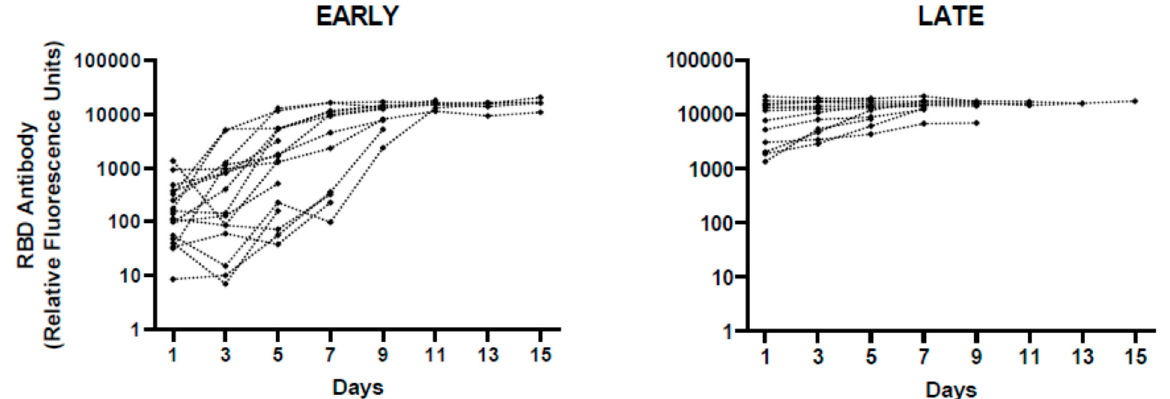
Figure 4. Receptor-binding domain (RBD) antibody response in COVID-19 patients. Relative RBD IgG concentrations in early and late infection groups are shown over the course of hospitalization. RBD value of 1100 on the first day of hospi- talization was used to distinguish early and late stages of infections. N = 20 for early and 16 for late groups.